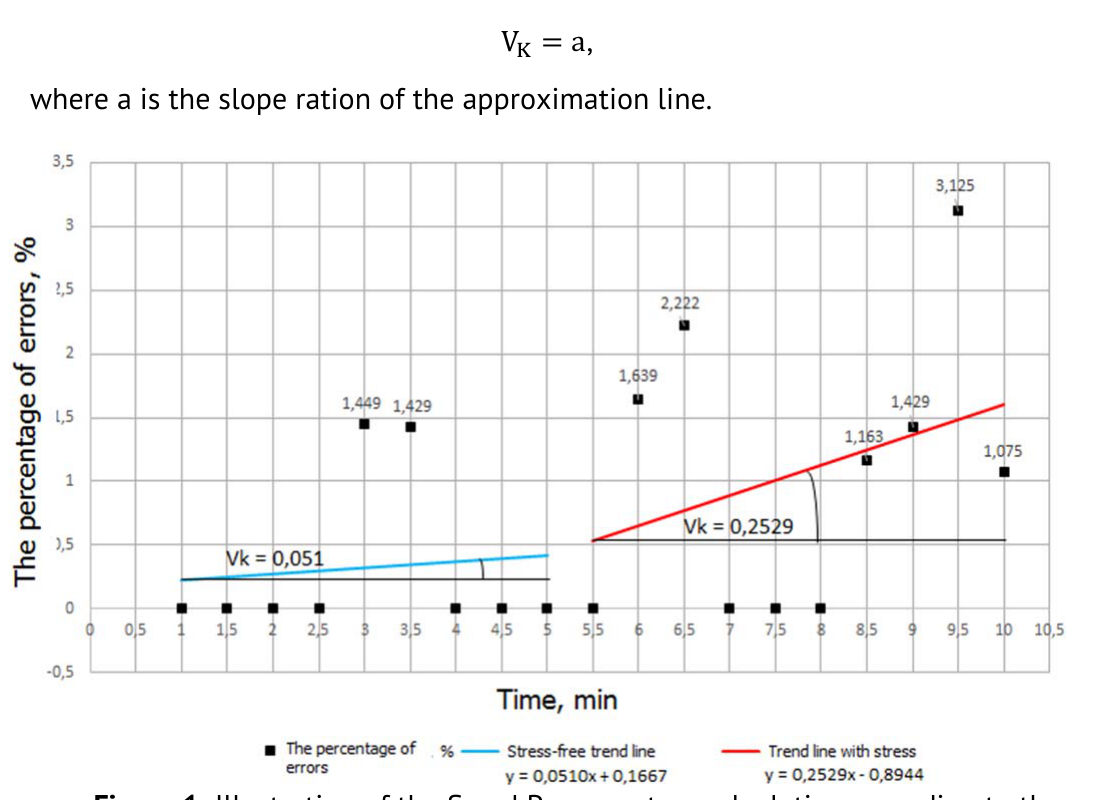
Figure 1. Illustration of the S and P parameters calculation according to the approximation